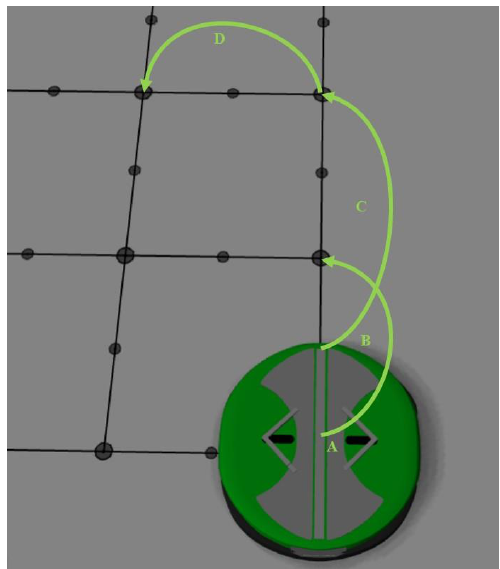
Figure 6. An example of the activation types.